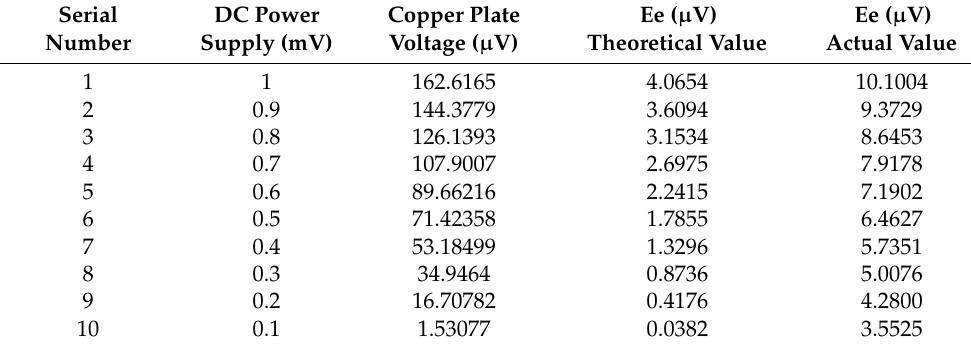
Table 1. DC electric field test results.